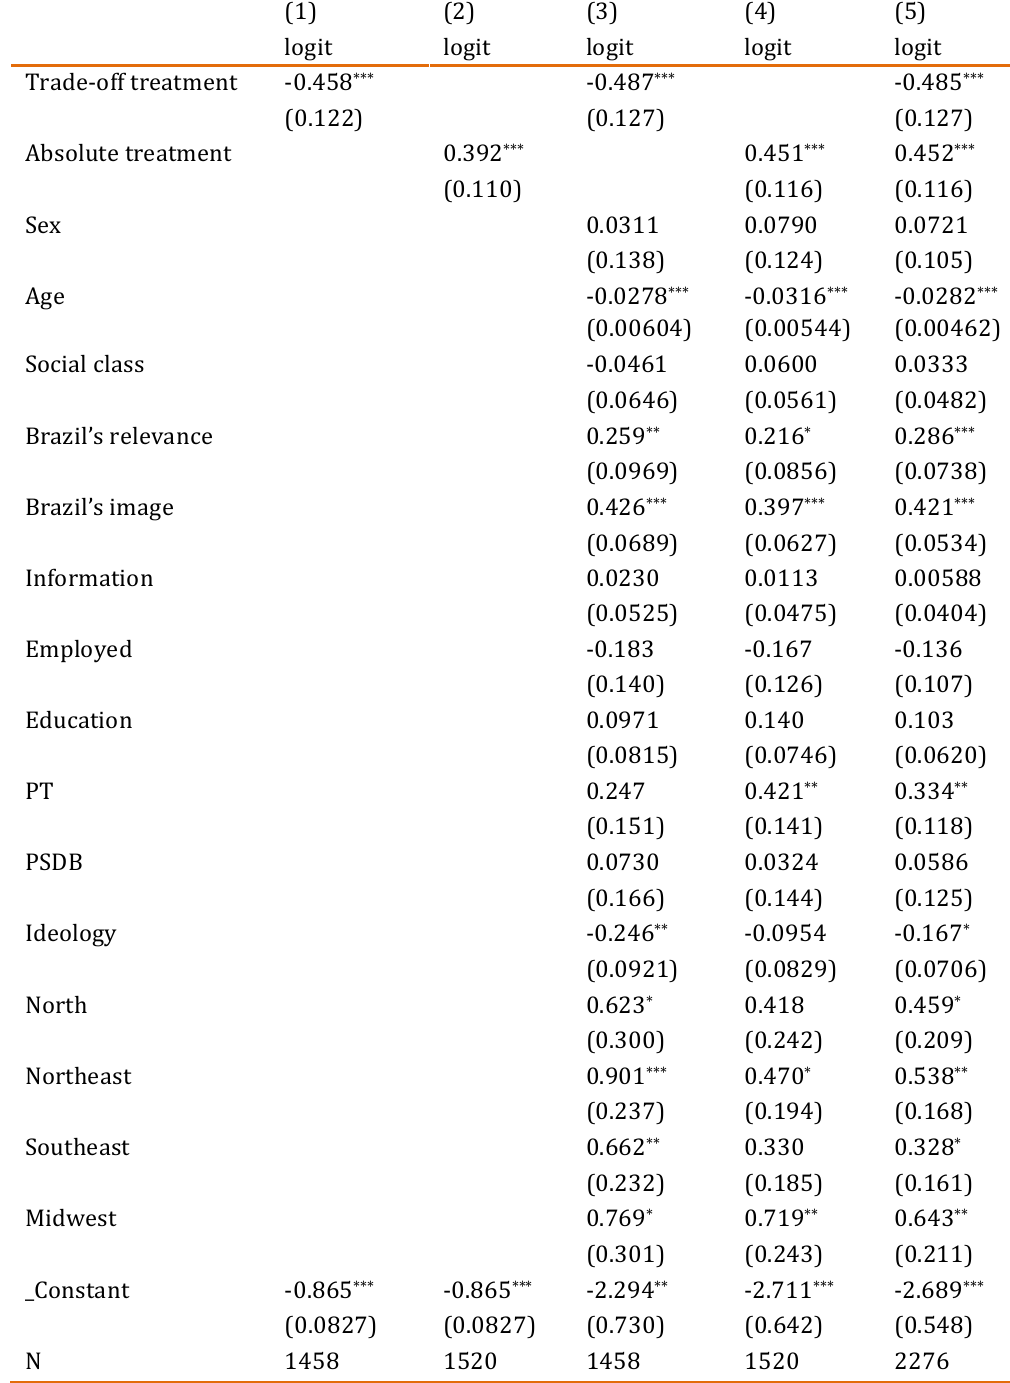
Table 02. Framing effects with control